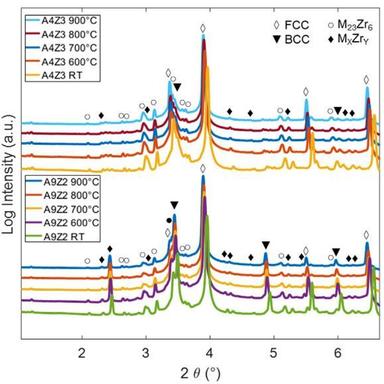
HEXRD spectra acquired for both alloys at RT and at 600 °C, 700 °C, 800 °C, and 900 °C in the undeformed state. For colors, please see digital version.